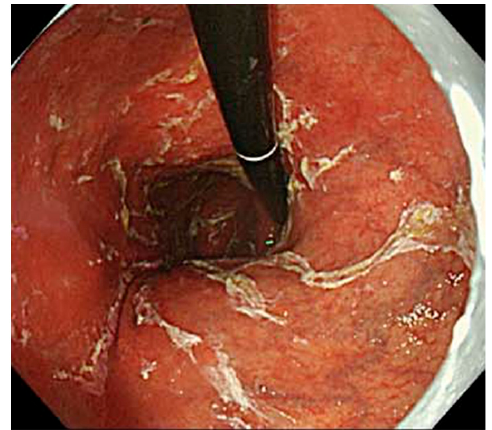
Figure 5. Images of sticky adherent dense mucus.